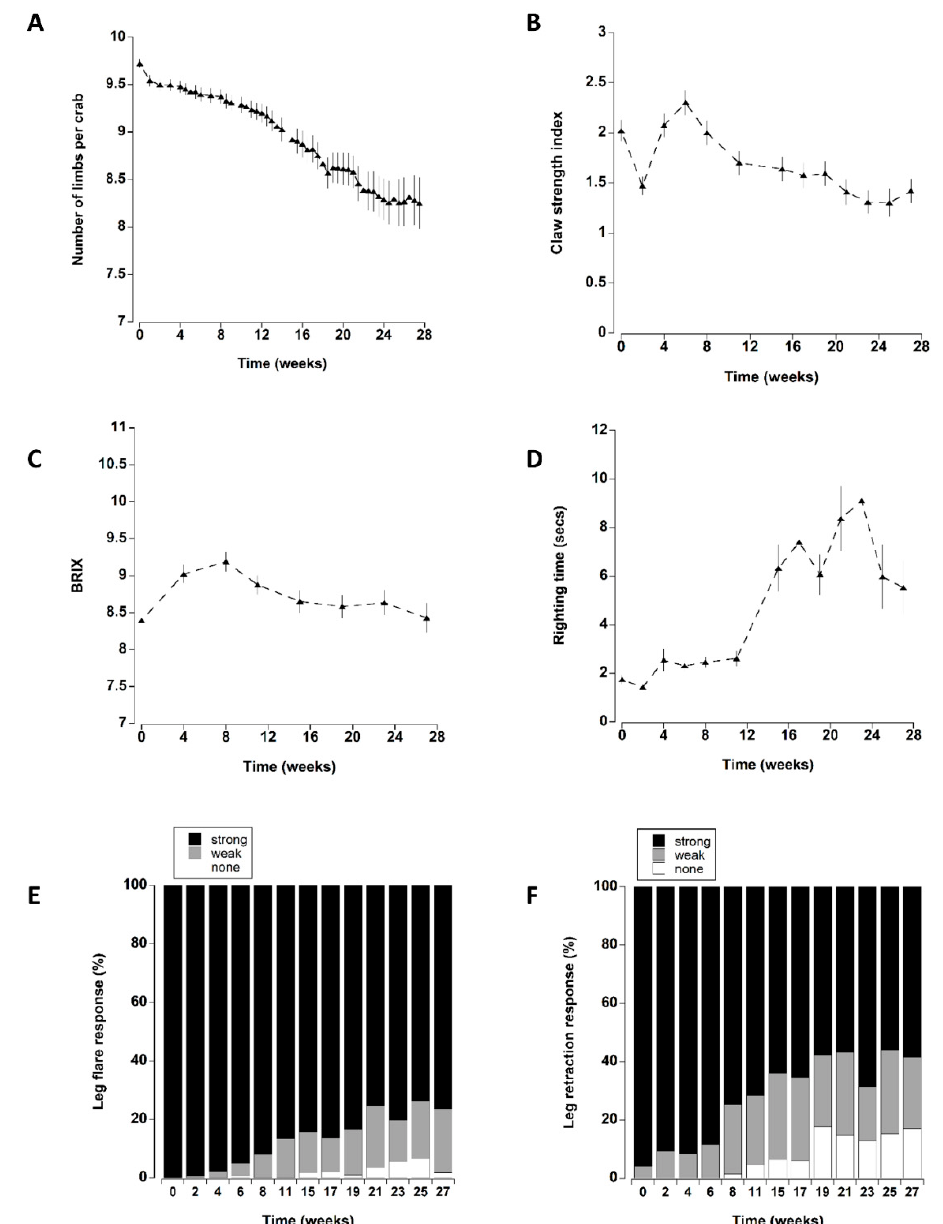
Figure 8. Data for all six treatments (density of 1, 4, 8 crabs, with or without shelter) combined to show changes over time. ( A ) Number of limbs remaining per crab. ( B ) Claw strength index ( C ) BRIX values and ( D ) righting time (seconds): data for these four graphs represent the mean ± SE. ( E ) Leg flare and ( F ) Leg retraction expressed as percentage of animals (remaining alive) exhibiting a strong, weak or no response.